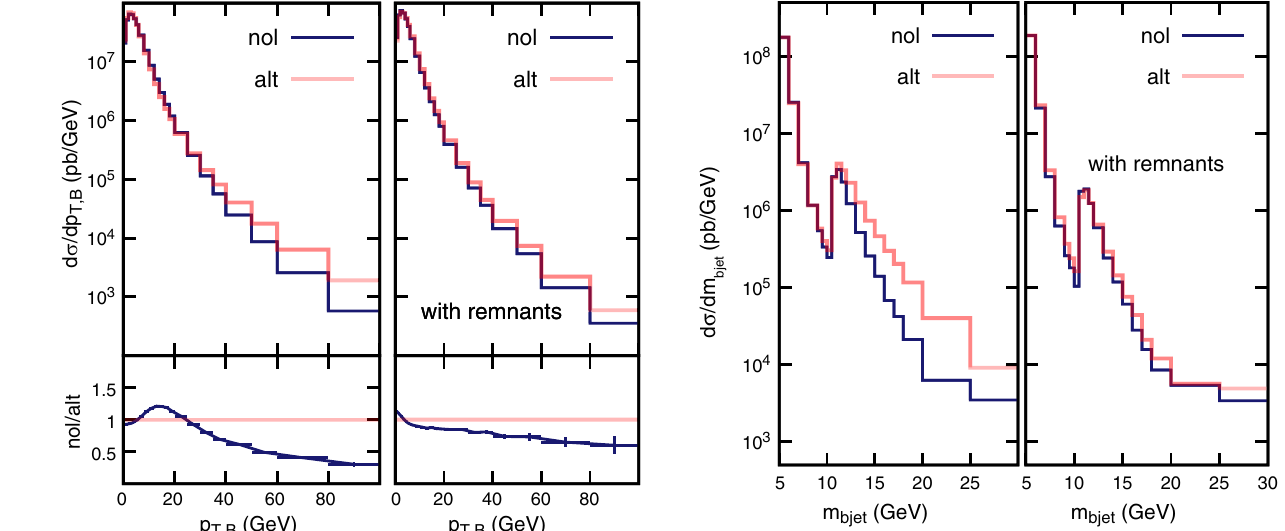
are evaluated by default at a scale equal to the transverse mass of the heavy quark at the level of the underlying Born